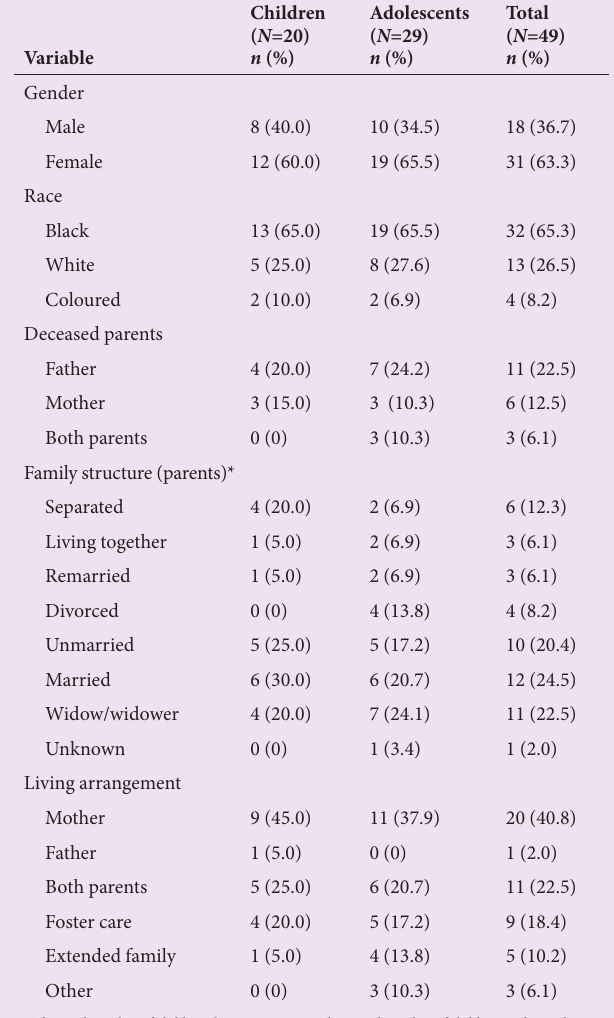
Table 1. Participant sociodemographic